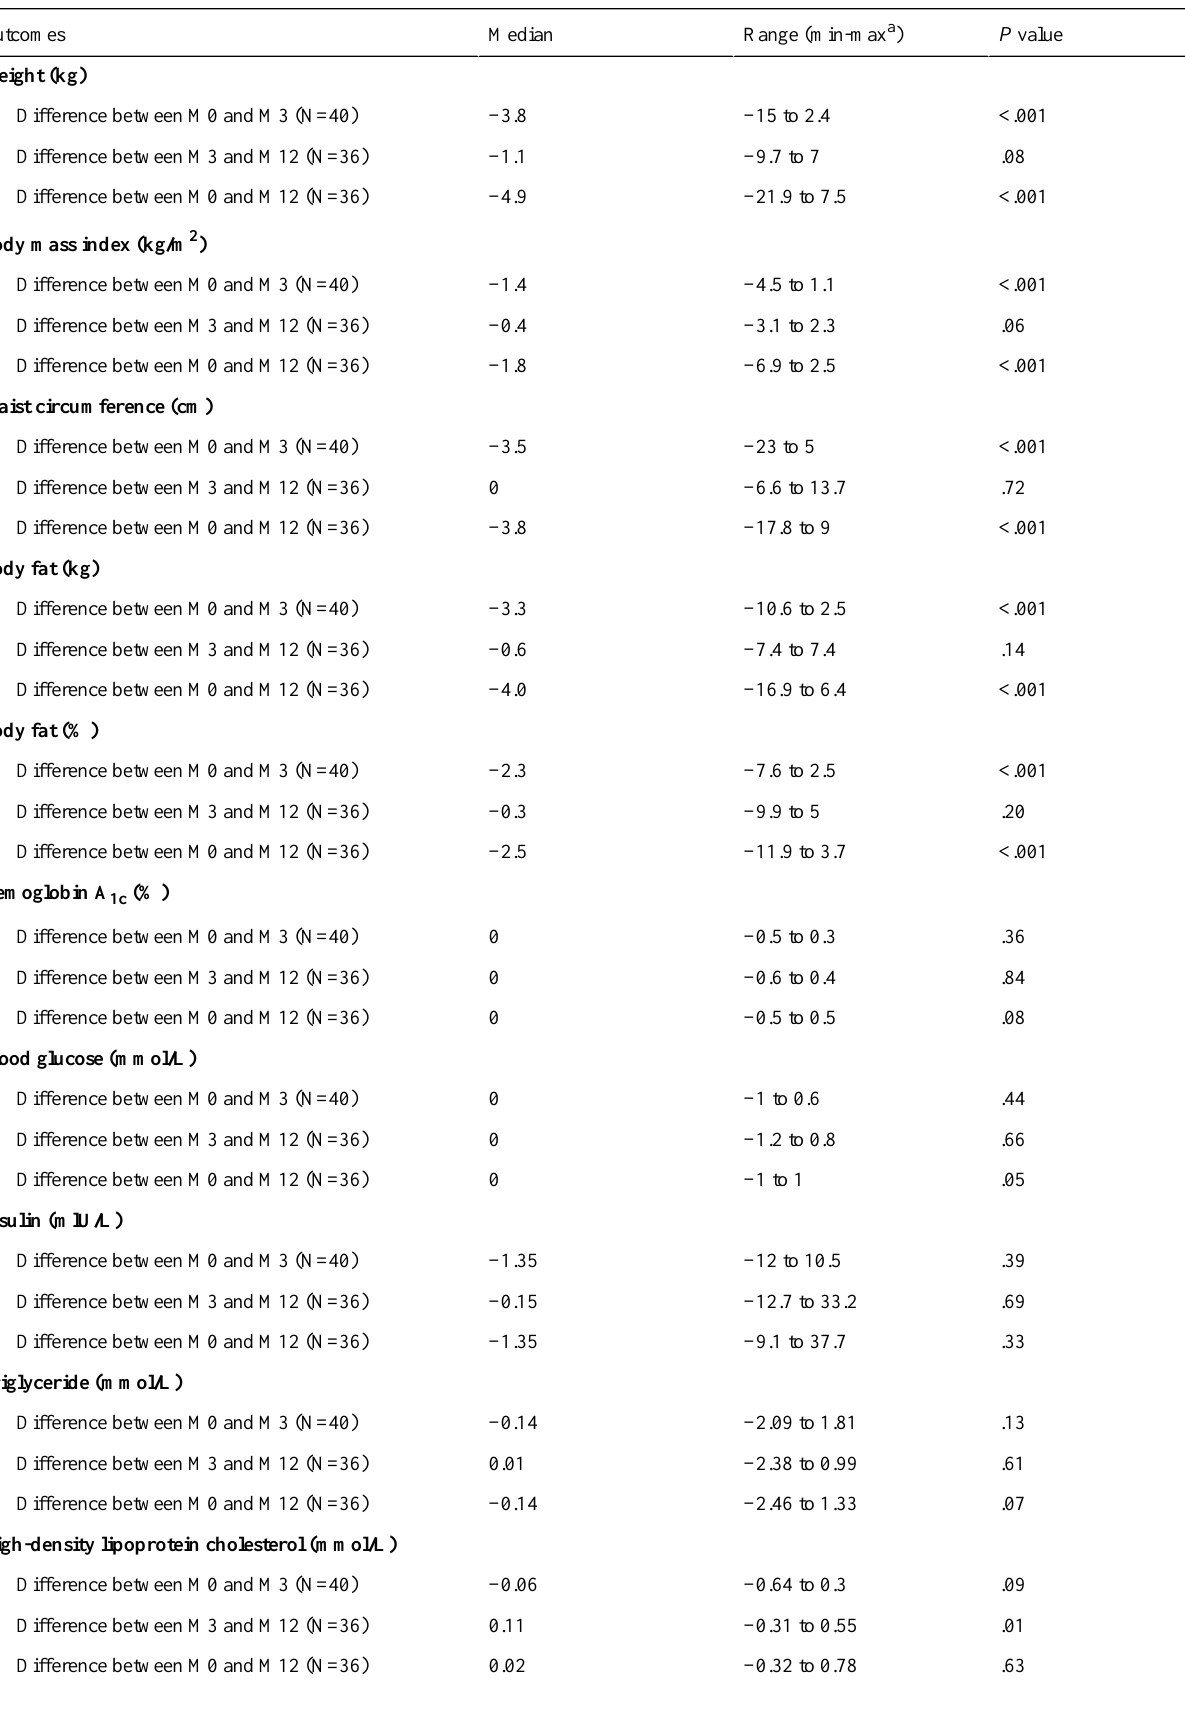
Table 2. Changes in anthropometric measurements and other metabolic risk factors between baseline (M0) 3 months (M3), and 12 months